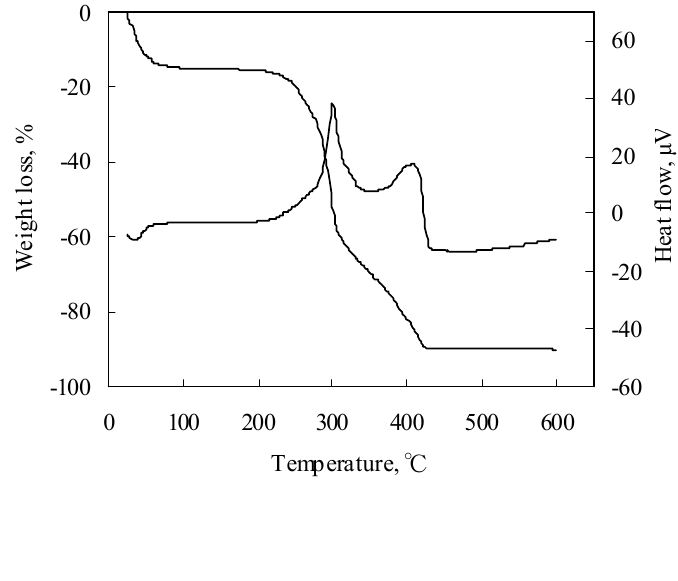
Figure 8. TG-DTA curves of wood chips (Sample: 20 mg; Heating rate: 2